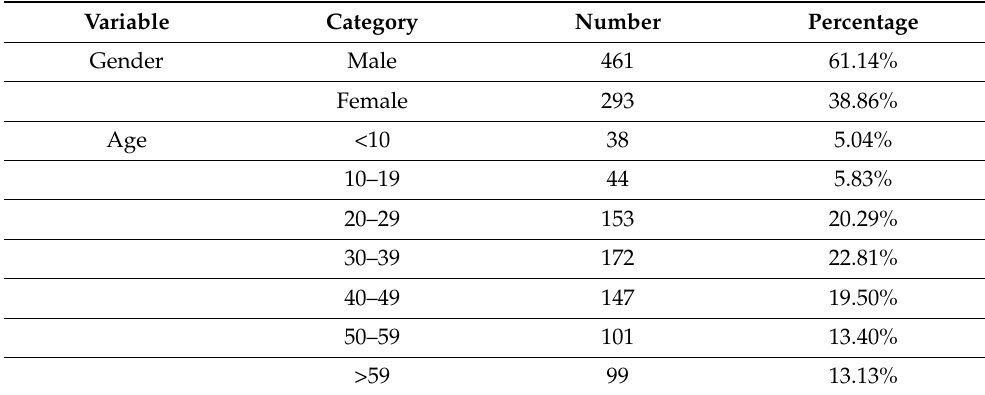
Table 2. The personal data of the patients who received antibiotics in the surgical ward.